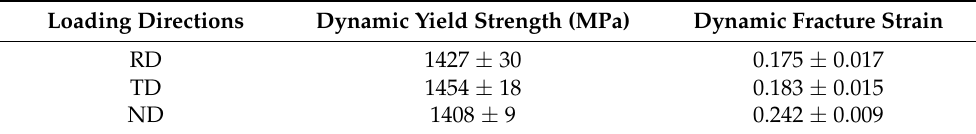
Table 1. Dynamic compressive mechanical performance of TC4 alloy plate.